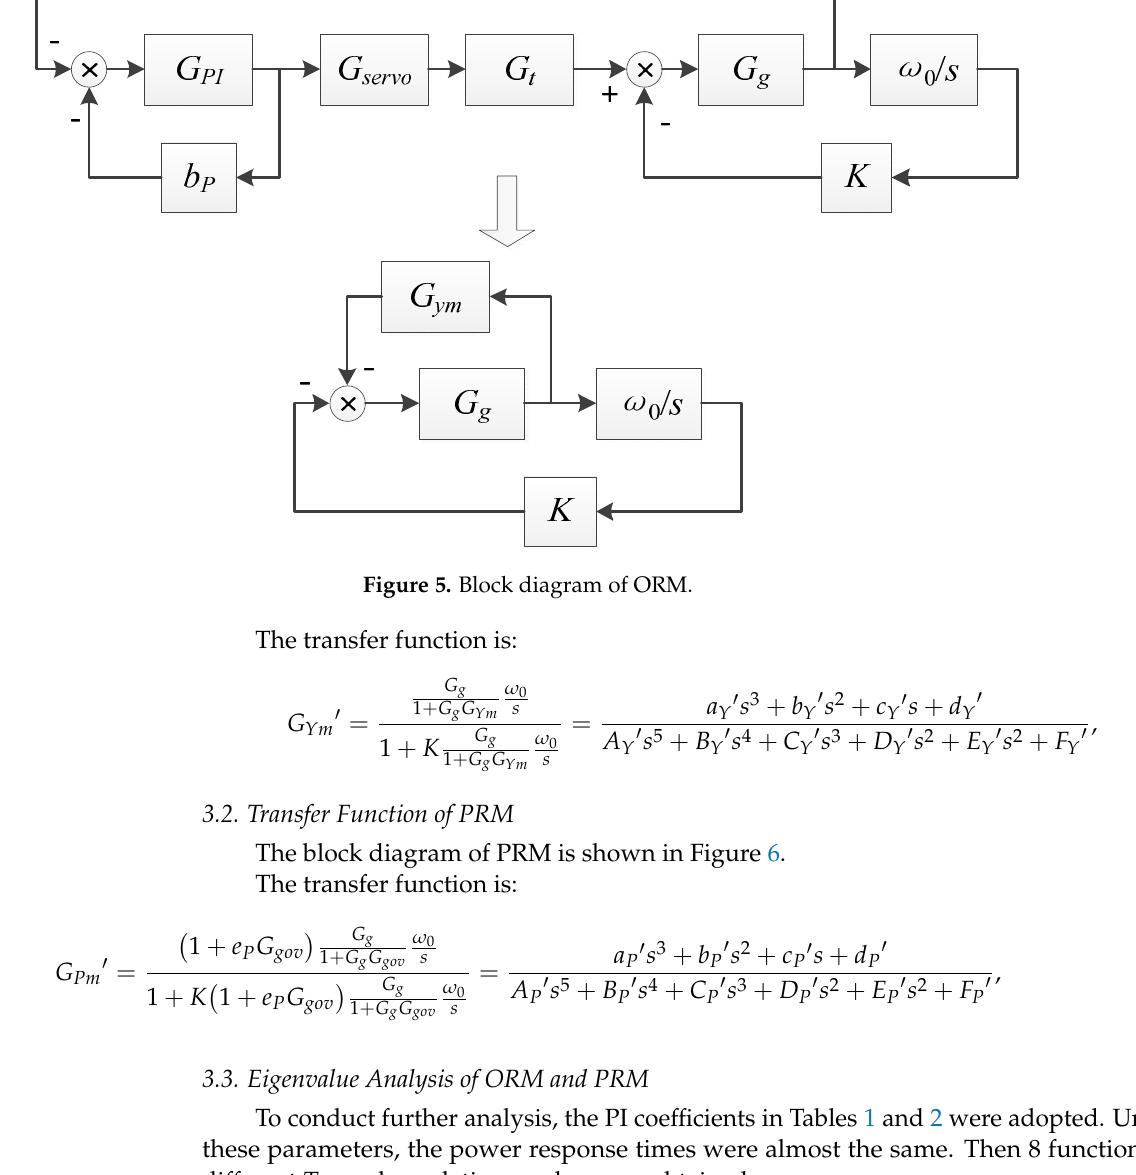
Figure 4. Bode graphs of G Pm ( s ) with different T W : ( a ) T W = 0.2; ( b ) T W = 1.2; ( c ) T W = 2.2; ( d ) T W = 3.2.